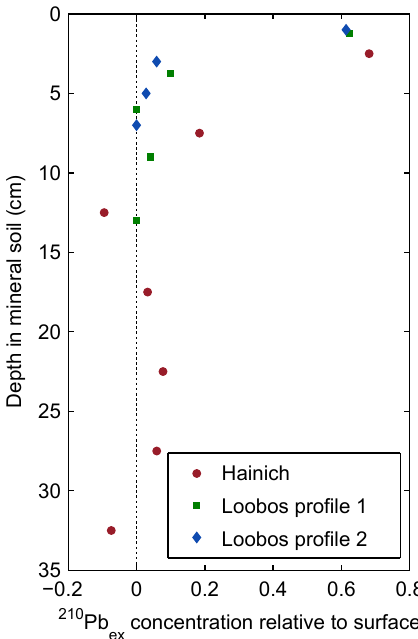
Fig. 2. Measured 210 Pb ex concentrations used for the calibration. Concentrations are relative to the values at the surface. Note that the 210 Pb ex measurements for Loobos are taken from an equivalent site (Kaste et al., 2007).